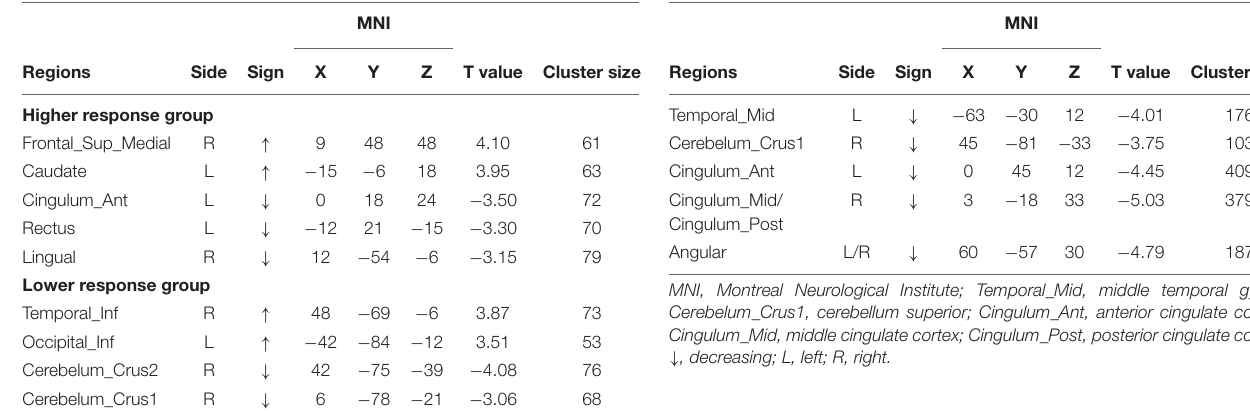
TABLE 3 | The cerebral activity changes in higher/lower group. TABLE 4 | Changes of mPFC rsFC in higher response group.